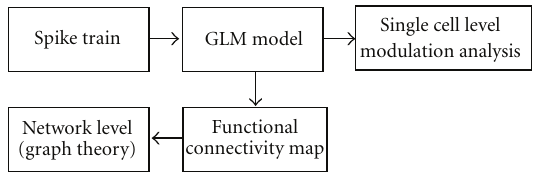
Figure 5: Sketch of the GLM-based plasticity analysis.